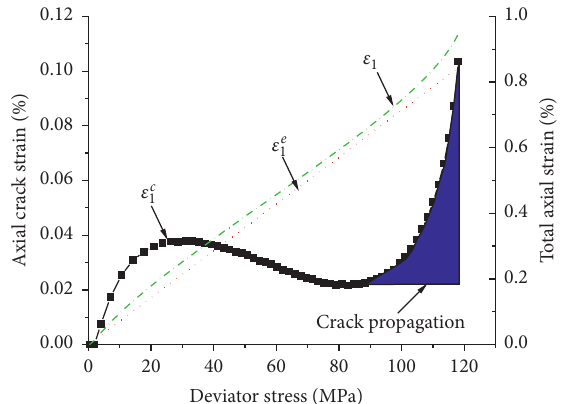
Figure 15: Axial crack strain curve of sample